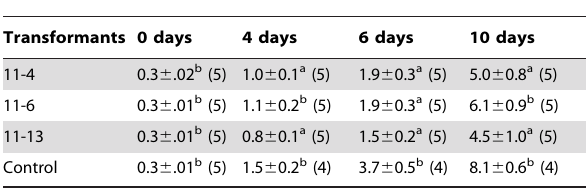
Table 3. Weights of tobacco hornworm larvae feeding on N. benthamiana T2 homozygous plants transformed with the BvSTI